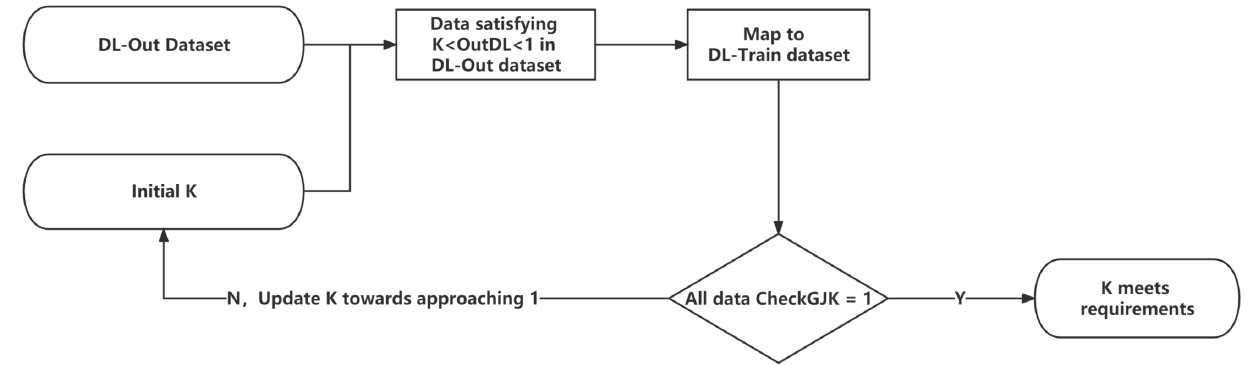
Figure 14. Flowchart for finding the K-value that satisfies the requirements.